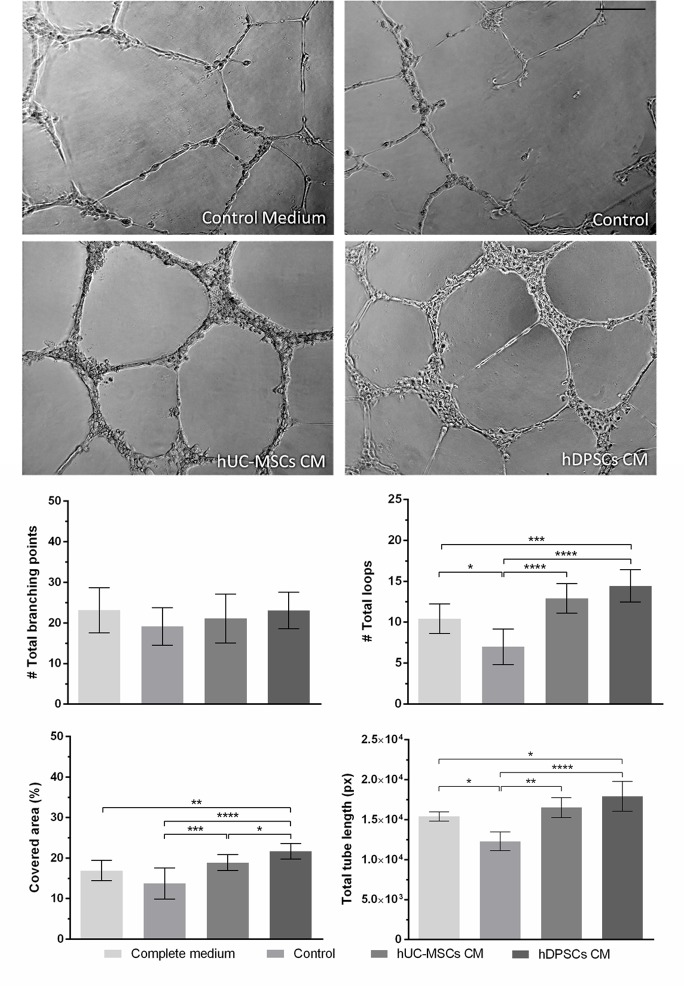
Tube formation assay.After 12 hours of UVECs exposure to Complete, Control, UC-MSCs or DPSCs supplemented media (upper panel). Graphical representation of total branching points, total loops, covered area and total tube length observed in each group (lower panel) (scale bar = 200 μm). Values are presented as Mean ± SD. Significant differences indicated according to P values with one, two, three or four of the symbols (*) corresponding to 0.01≤P<0.05; 0.001≤P<0.01; 0.0001≤P<0.001 and P<0.0001, respectively.